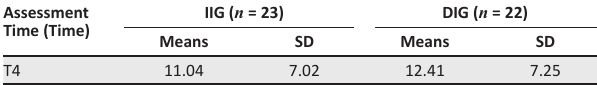
TABLE 2b: Means and standard deviations for the total score on the Penn State Worry Questionnaire for Children for the immediate intervention group ( n = 27) and delayed intervention group ( n = 25) from T1 to